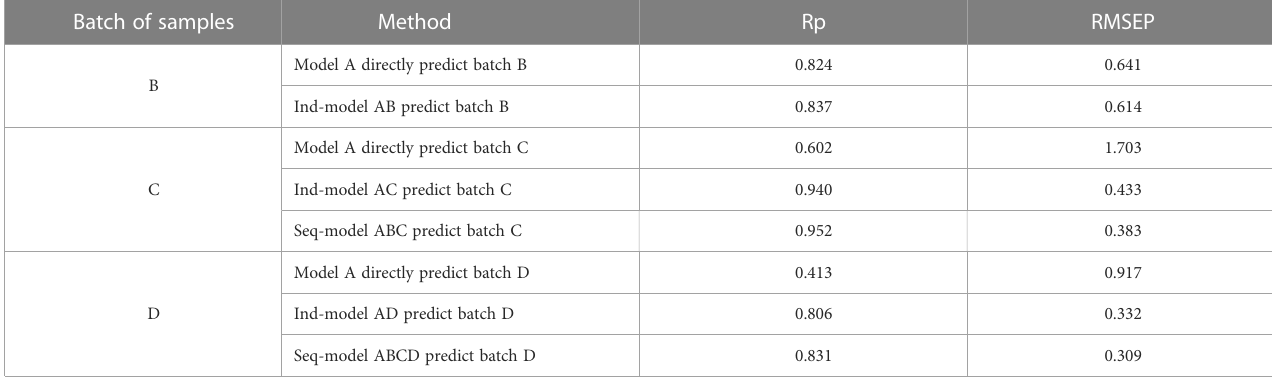
TABLE 5 Robustness of different updated model based on NIR spectroscopy for detecting LC in snow pear. Batch of